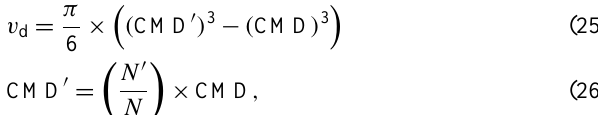
number concentration of the particles was obtained. Because the particle CMD is the function of particle number